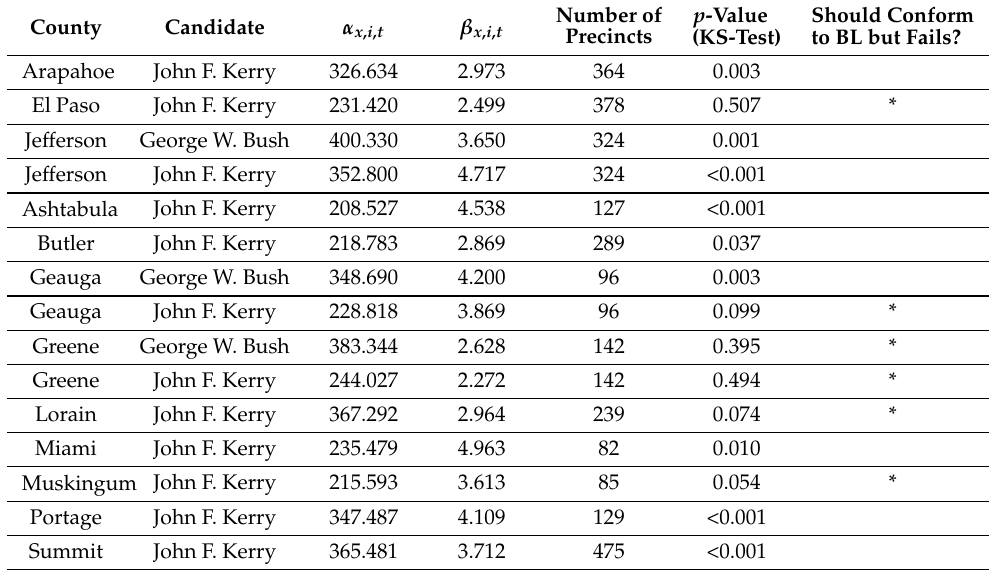
Table 7. Analysis of Whether Anomalous Counties from Table 6 Deviate from Benford’s Law. County Candidate α x , i , t β x , i , t